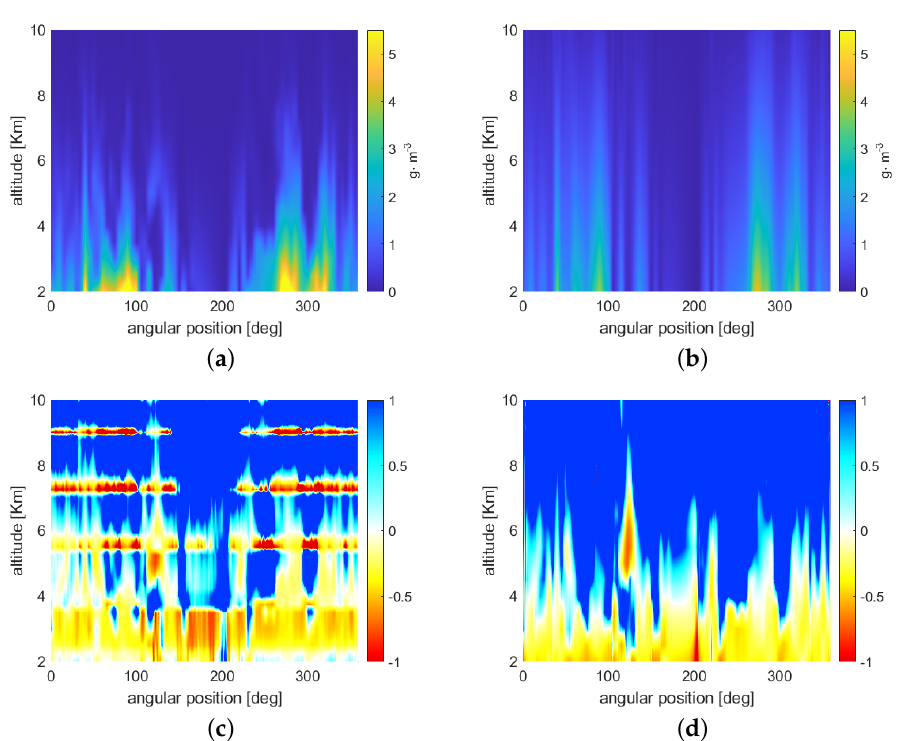
Figure 7. Reconstructed WV maps obtained with the least squares algorithm with Tikhonov regular- ization ( a ) and with the exterior reconstruction solution ( b ). In plots ( c ) and ( d ) (for the same methods and in the same order), the errors between the retrieved WV field and the original one, normalised with respect to the latter quantity, are